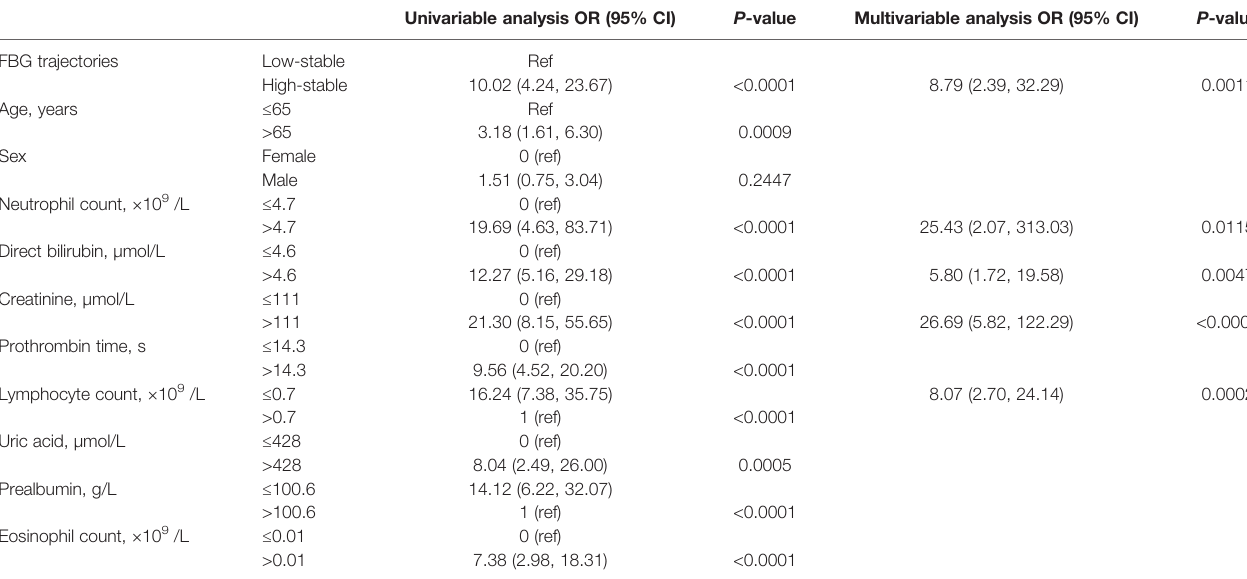
TABLE 2 | Univariable and multivariable analyses for death concerning all study patients. Univariable analysis OR (95%